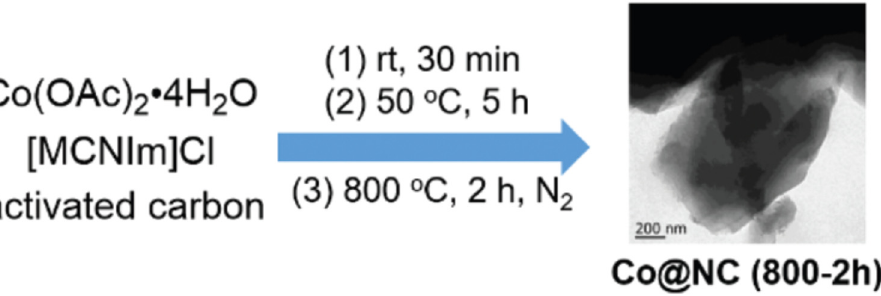
Figure 1. The procedure for the synthesis of Co@NC (800-2 h). Reprinted with permission from Ref. [25] . Copyright © The Royal Society of Chemistry 2018. Ref. [25]. Copyright © The Royal Society of Chemistry